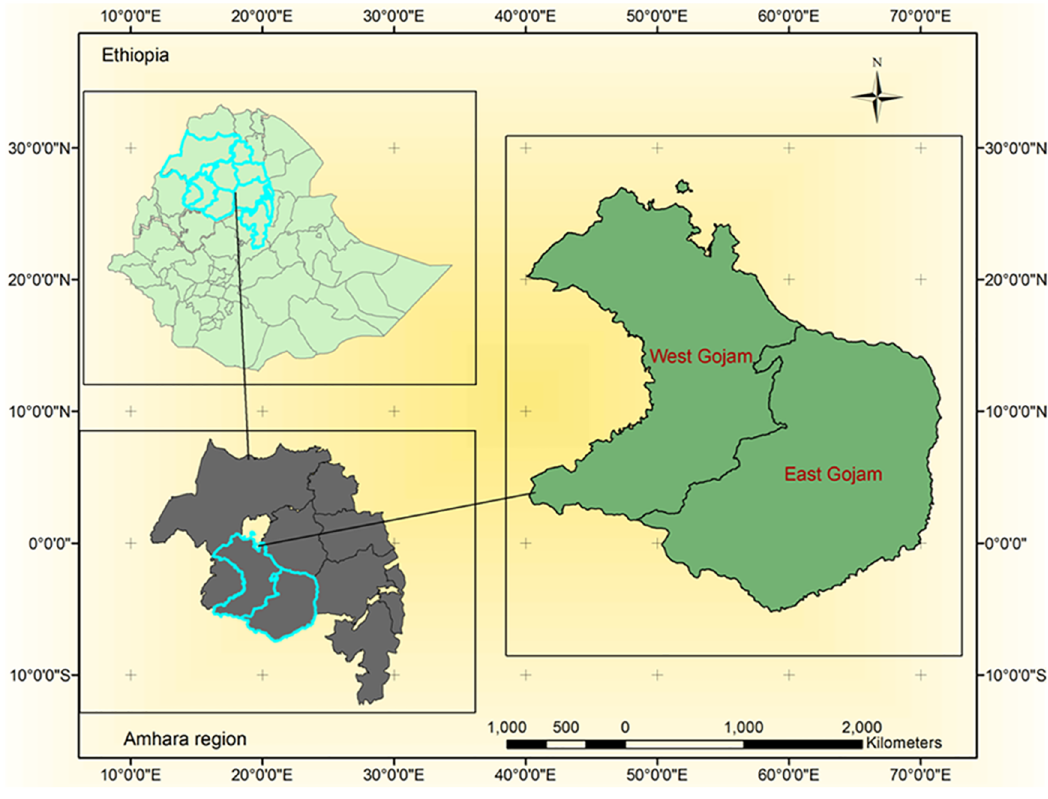
Fig 1. Map of the study population